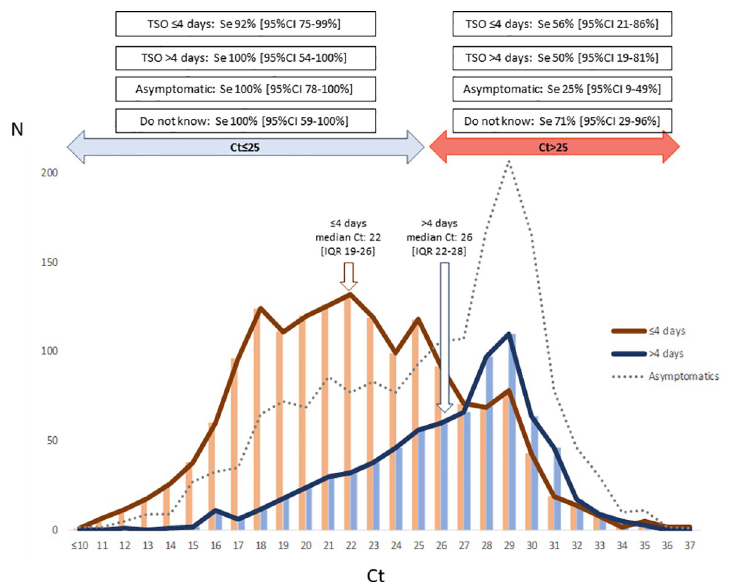
Fig 2. Ct values according to time from symptoms onset, and sensitivities of rapid antigen detection assay according to Ct and time from symptoms onset. TSO, time from symptoms